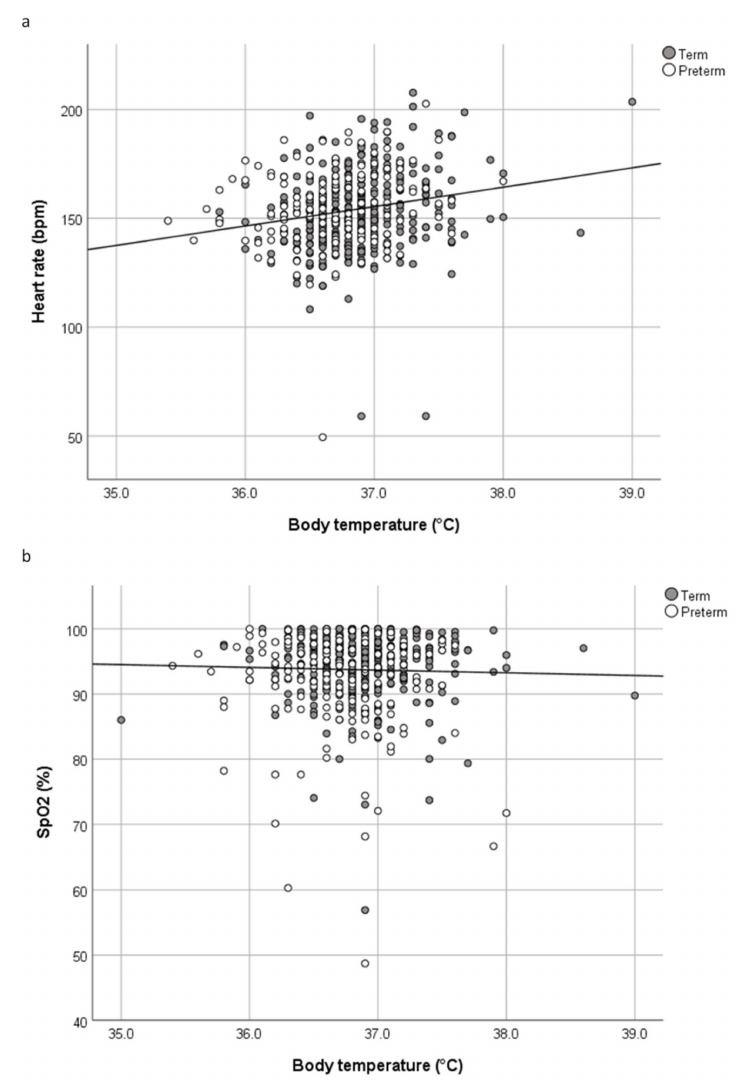
Figure 2. ( a ) Scatter plot of heart rate in beats per minute (bpm) and body temperature ( ◦ C) in term and preterm neonates. ( b ) Scatter plot of arterial oxygen saturation (SpO 2 )% and body temperature ( ◦ C) in term and preterm neonates. Table 2. Correlation analyses of body temperature in degrees Celsius ( ◦ C) and cerebral tissue oxygen saturation (crSO 2 / cTOI), peripheral tissue oxygen saturation (prSO 2 ), peripheral fractional